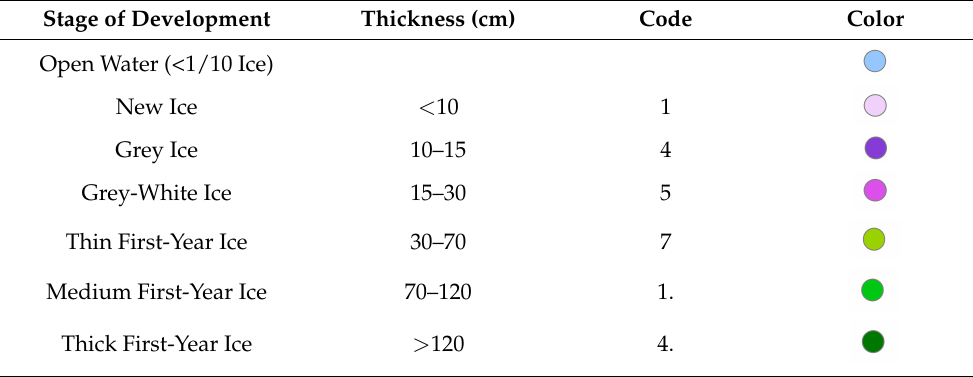
Table 2. Information of sea ice types used in this